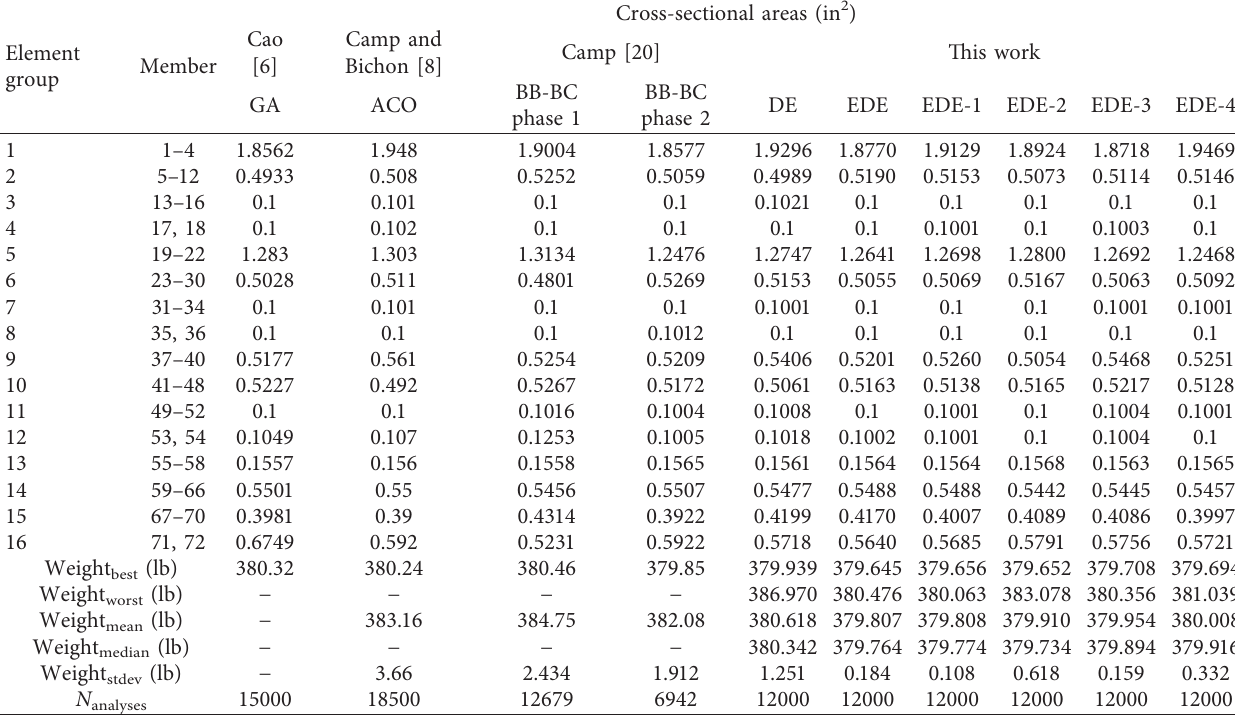
Table 6: Performance comparison of the 72-bar truss.